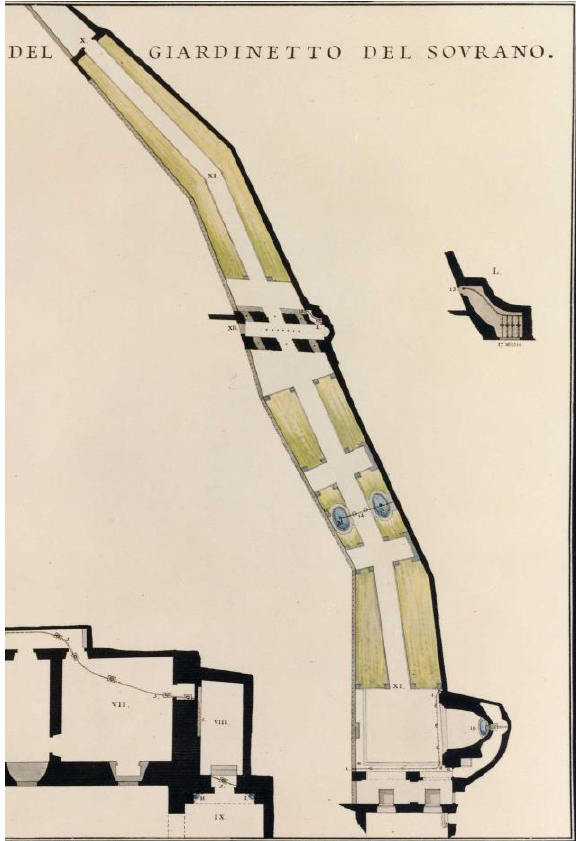
Figure 3: Pasquale Poccianti (attr.), Pianta del Cortile della Dispensa, e suoi annessi, e del Giardinetto del Sovrano ,